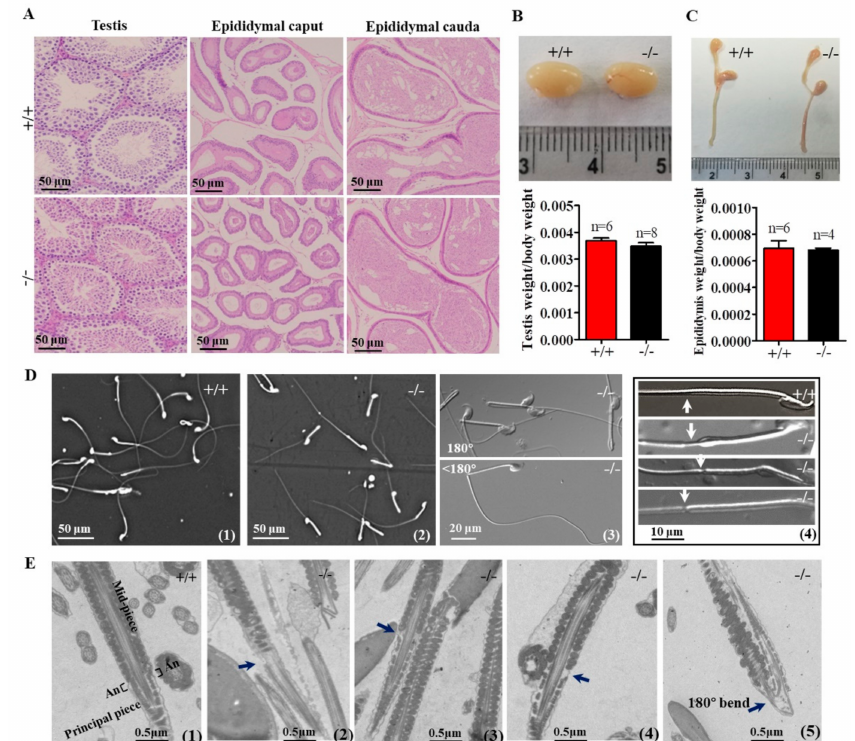
Figure 3. Testicular, epididymal, and spermatozoa phenotypes. ( A ) Histological analyses of the testis and epididymis sections from wild-type (WT) and calcium-binding protein spermatid-associated 1 knockout ( Cabs1 − / − ) mice stained with hematoxylin and eosin. ( B , C ) Representative pictures and weights of testes and epididymites from WT and Cabs1 − / − mice. ( D ) Phase contrast images of spermatozoa collected from the cauda epididymis of adult WT and Cabs1 − / − mice. Spermatozoa from Cabs1 − / − mice had a tail bent at the midpiece–principal piece junction and a thinning of the annulus (white arrows). ( E ) Ultrastructural analysis (via transmission electron microscopy) of sperm flagella from WT and Cabs1 − / − mice. Flagella sections of normal and mutant sperm showing the thinning of annulus and tail bending (black arrows). ( 1 ) The annulus of sperm flagella from WT mice. ( 2 – 4 ) Deficient annulus of sperm flagella from Cabs1 − / − mice. ( 5 ) Bent